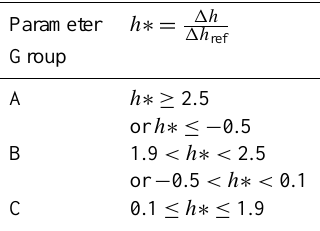
Table 4. Parameter groups definition for the ranking resulting from sensitivity